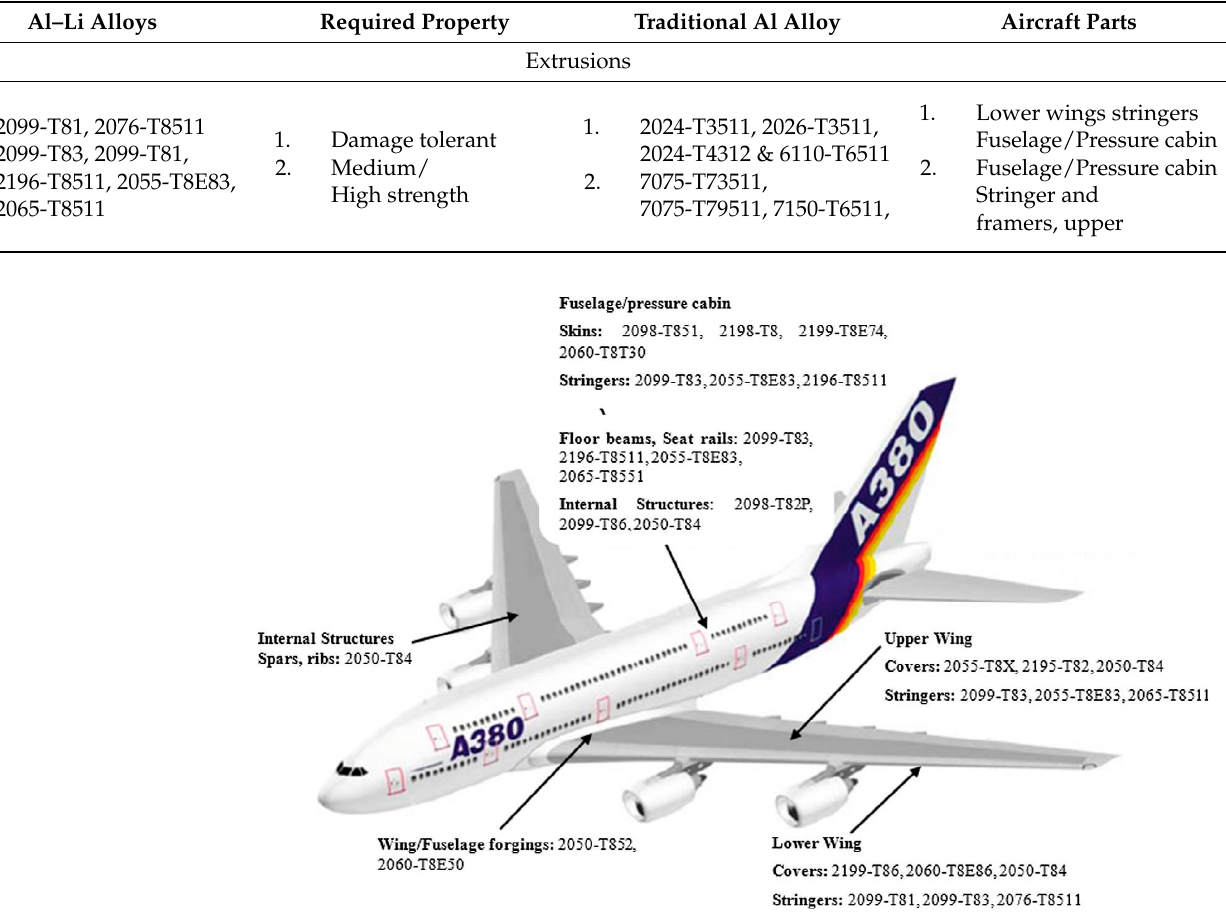
Figure 21. The used third generation of Al–Li alloys in the aircraft [143] (has permission from Elsevier).